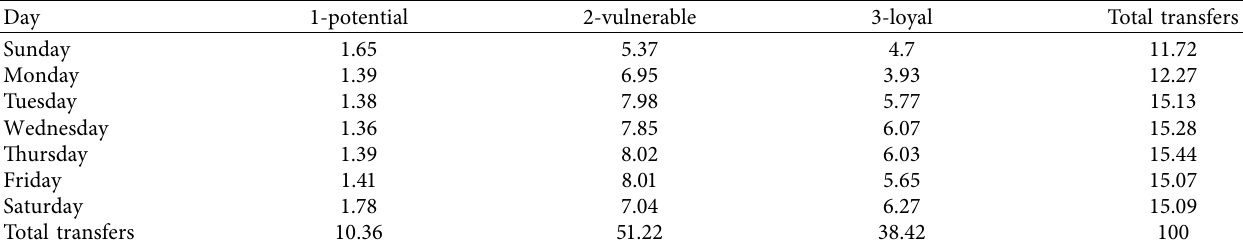
Table 16: % daily transfer distribution among target segments ( K � 3) in 2018.